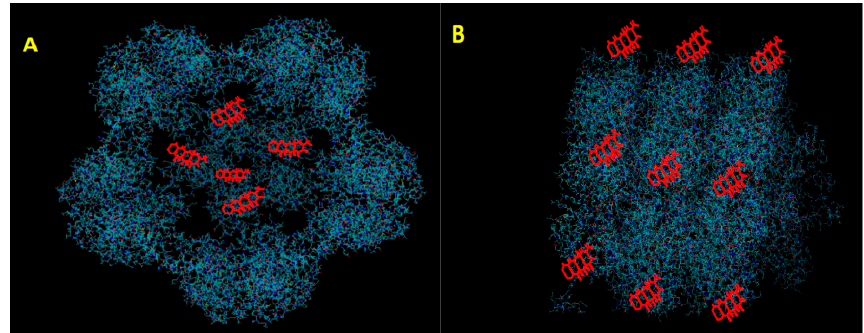
Figure 1. Schematic diagram of plant virus nanoparticles associated with Doxorubicine (DOX). In this diagram, DOX is oversized for visualization. ( A ) DOX residing within internal cavity of an icosahedral virus ( B ) DOX conjugated to the outer surface of a helical virus.